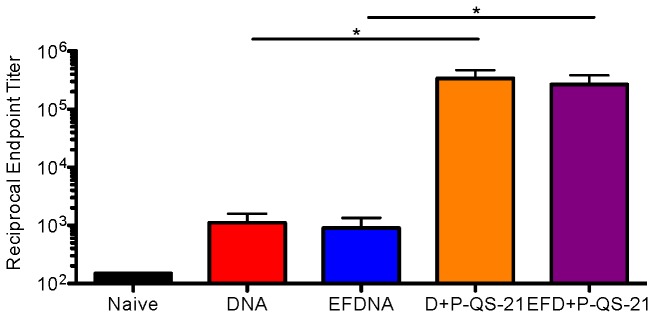
Endpoint gp120-specific IgG titer in C57Bl/6 mice immunized with endotoxin-free DNA prime versus regular DNA plasmid preparation.Total gp120-specific IgG was measured by ELISA in sera collected 7 days after the second protein boost, in week 13. Statistical analysis performed by one-way ANOVA and Tukey post-test (*: p<0.05).